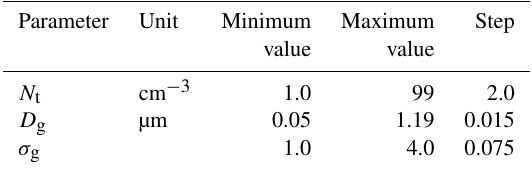
Table 3. Lognormal mode fitting parameters and resolution (step) used to derive Mie scattering sea spray mode